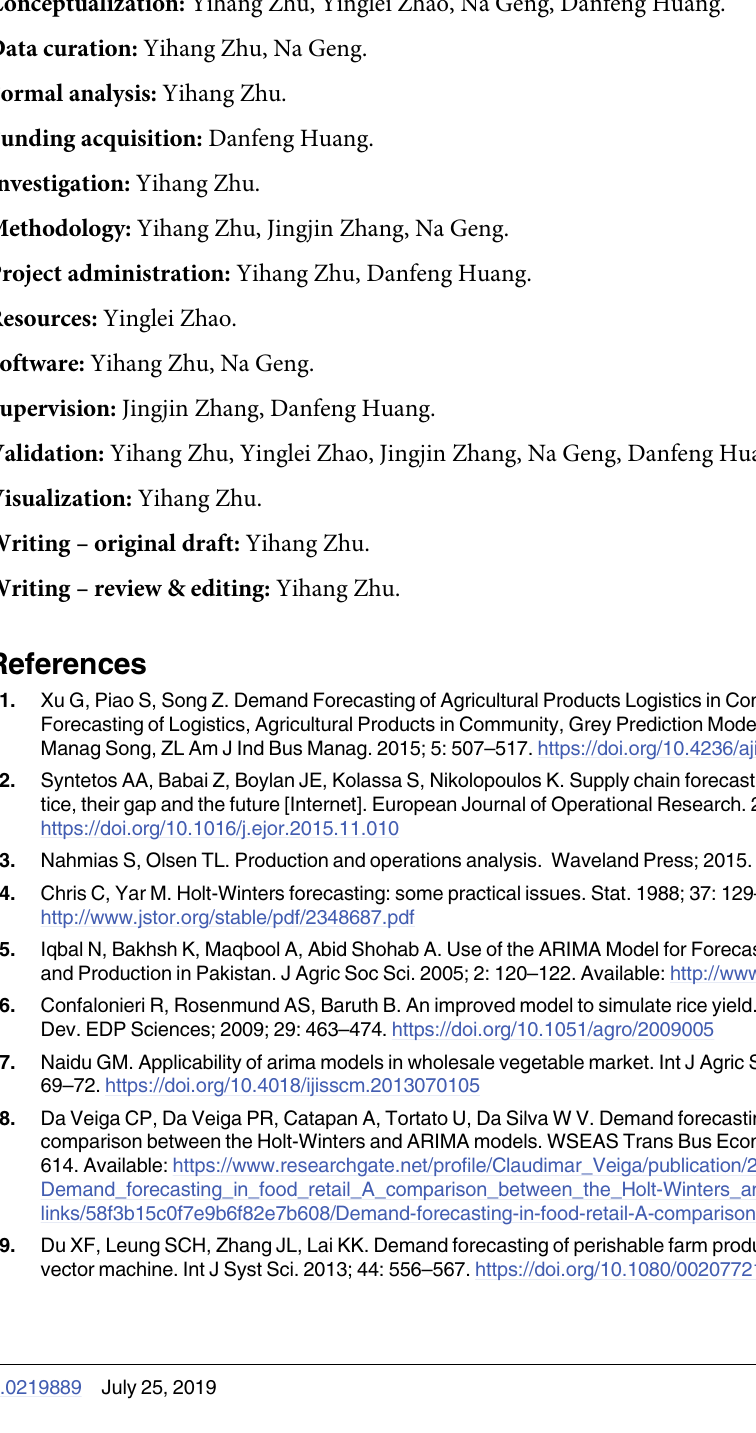
S3 Table. Spring onion market price, temperature and precipitation data.